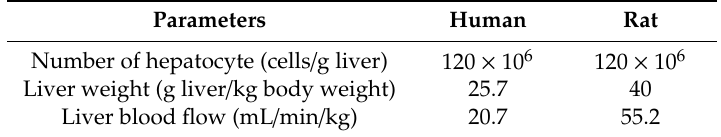
Table 2. Physiological parameters used for scaling CL int, in vitro to CL int, in vivo in humans and